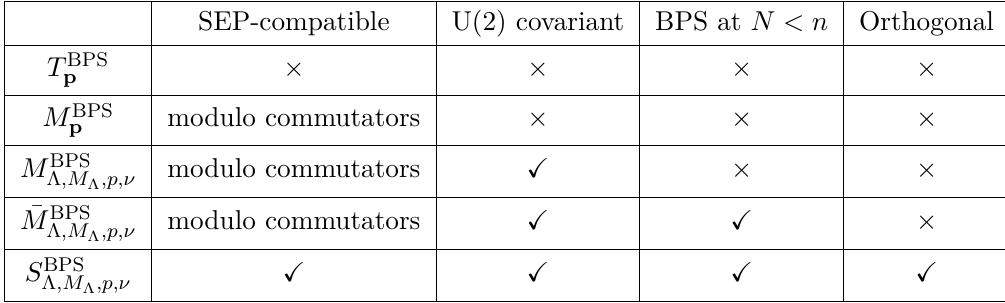
Table 2 . Properties of the different BPS bases constructed. All are BPS at N ≥ n